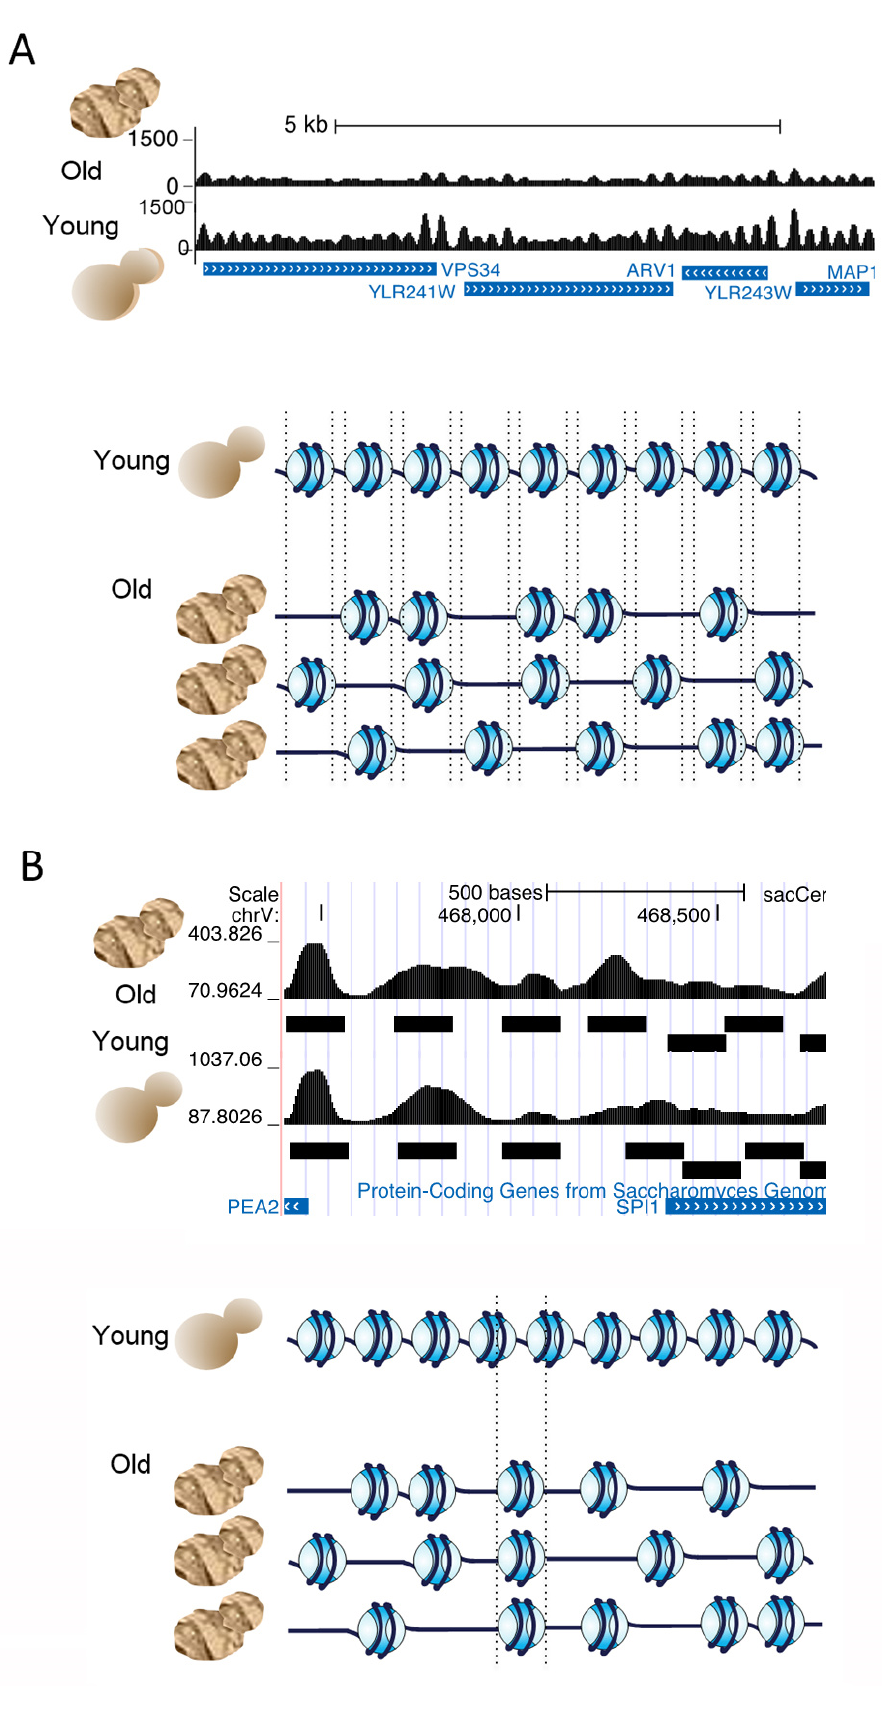
FIGURE 2: Changes in chromatin structure during aging. (A) Nu- cleosome occupancy is reduced by half over the entire yeast ge- nome in old cells, while position- ing of nucleosomes becomes fuzzier in old cells. The schematic at the bottom indicates that most nucleosome positions are re- tained within the population of old cells, while each cell has only half of the number of nucleo- somes. The dotted lines indicate that the nucleosomes in old cells can move to the left or right of the positions in young cells in the absence of steric hindrance from adjacent nucleosomes. (B) Some nucleosomes move significantly during aging, as shown by the nucleosome positioning tracks above and the schematic